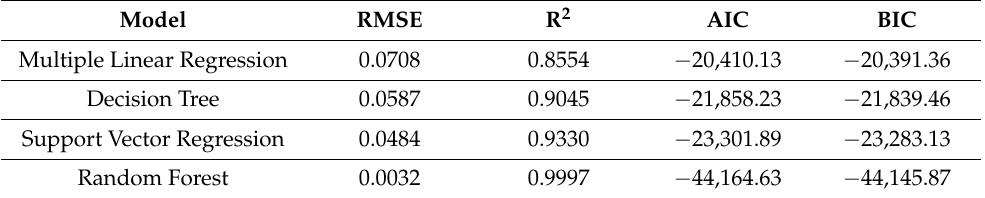
Table 3. Performance comparison of machine learning models for test data. Model RMSE R 2 AIC BIC Multiple Linear